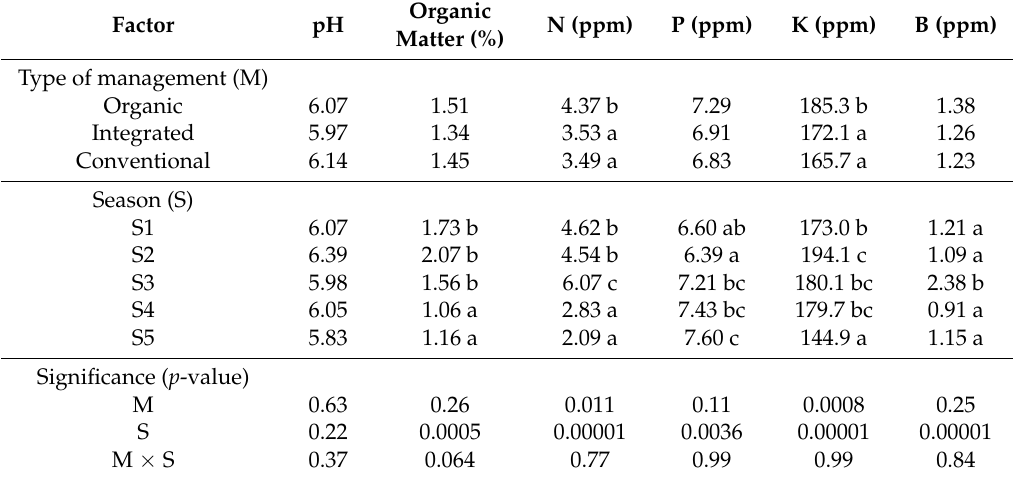
Table 5. Effect of organic, integrated and conventional management on soil physicochemical characteristics obtained from a Cabernet Sauvignon vineyard evaluated during 5 consecutive seasons.